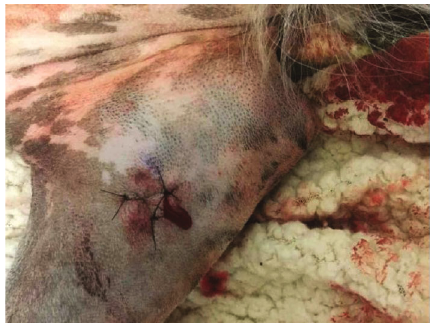
Figure 2: Case 3: dog hemorrhage post-intra-articular PPS